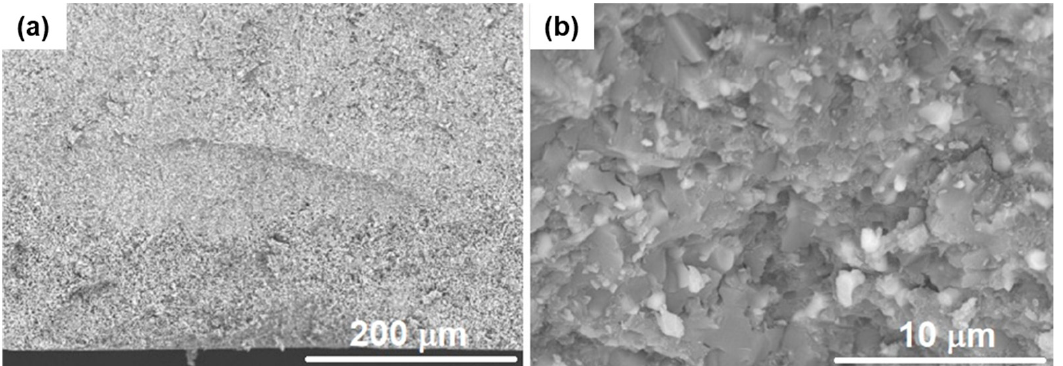
Figure 9. Characteristic fracture surface of the CZM-4A composite at ( a ) low magnification (250×), and ( b ) high magnification (5000×).